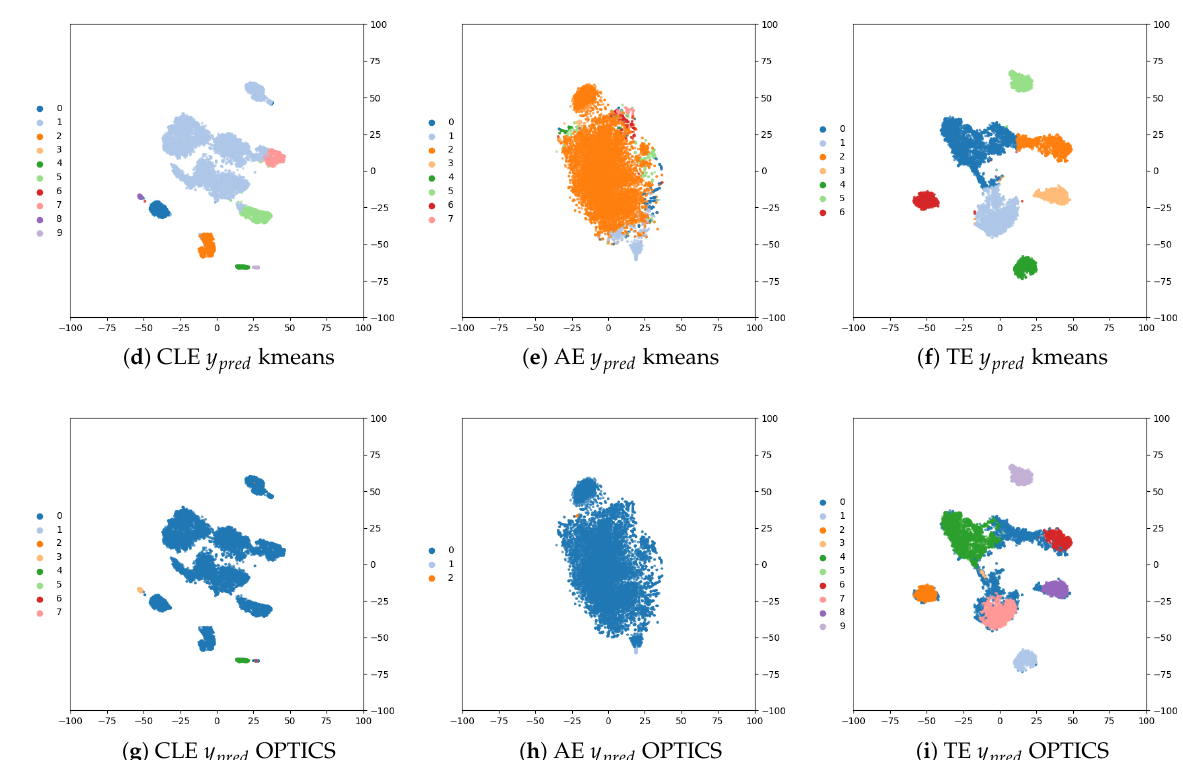
Figure 3. Case Study 2: t-SNE plot of feature space of the classifier encoder (first column), AE (second column), and triplet encoder (last column) model on T ∪ T p with the true labels (first row), the predicted labels with k-means (second row), and the predicted labels with OPTICS (last